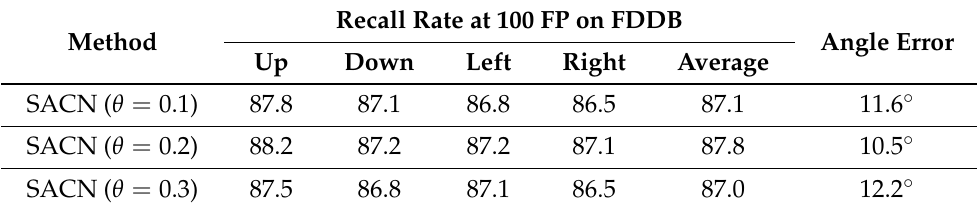
Table 2. Ablation experiment on the width controller of